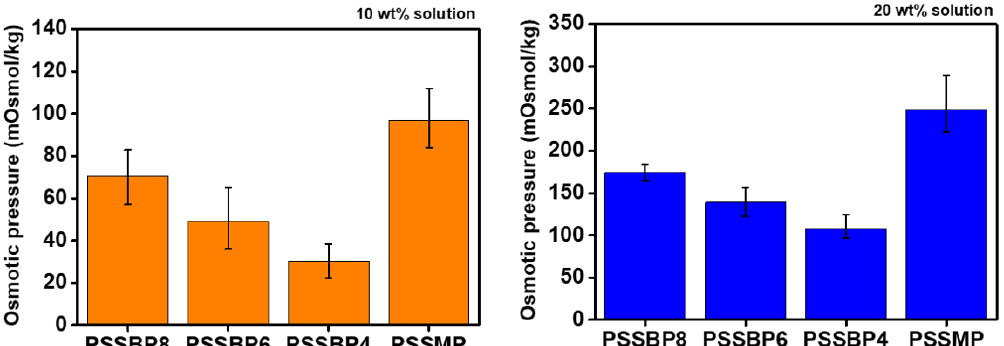
Figure 6. Osmotic pressure of the PSSBP# series and the PSSMP aqueous solutions according to solution concentration by cryoscopic method.